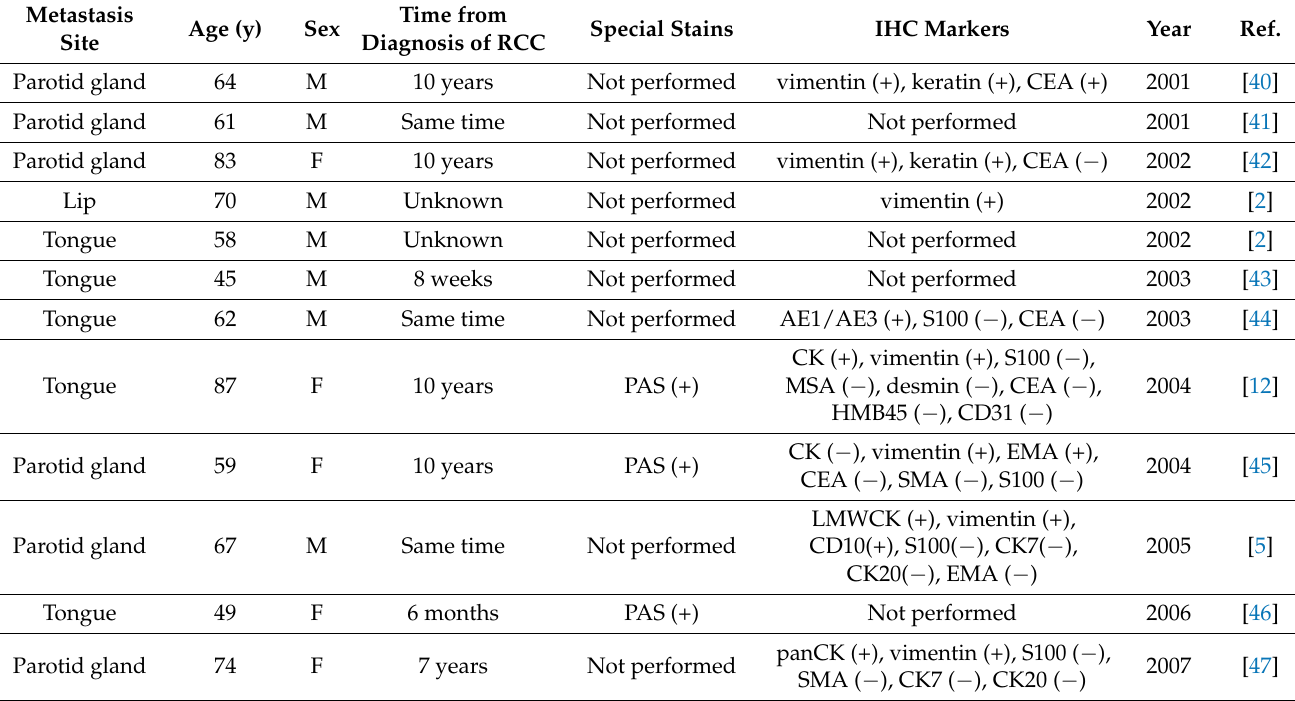
Table 2. Cases of metastases of renal cell carcinoma to the oral region: Review of the literature.